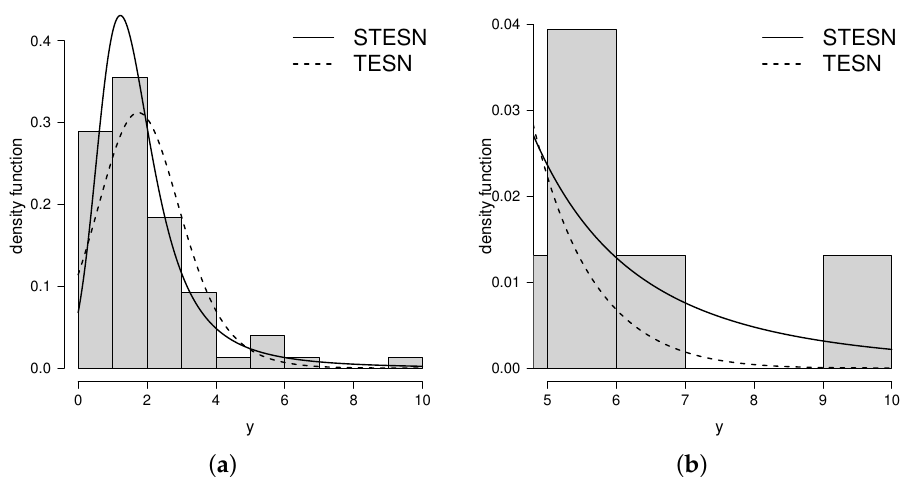
Figure 5. Estimated pdf for STESN and TESN for kevlar data set ( a ) and a zoom for the right tail ( b ).